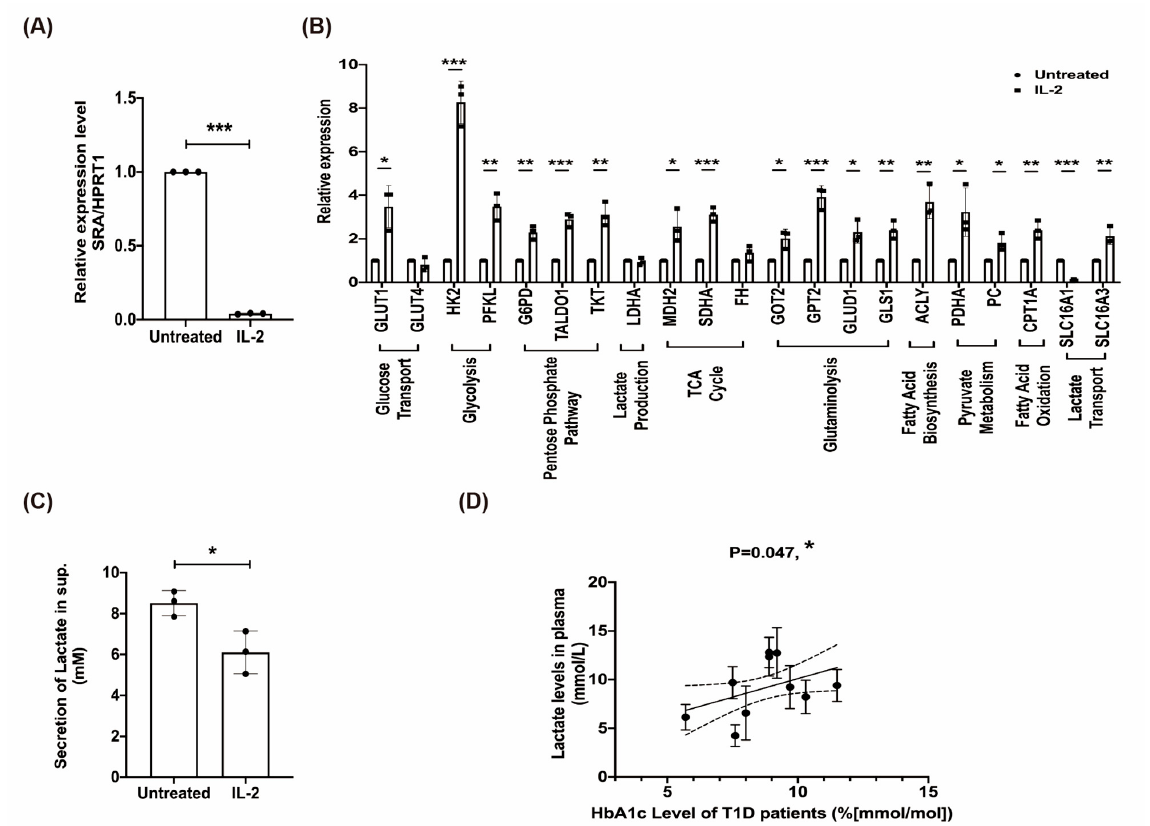
Figure 6. The effect of recombinant human IL-2 (rhIL-2) treatment on the expression of lncRNA SRA, metabolic pathways in MIN6 β -cells, and lactate associated with poor clinical outcome. The cellular expression of ( A ) SRA was assessed in cells using real-time qPCR after 48 h of treatment with rhIL-2 (200 units/mL) and compared with that of the untreated control cells. * significant changes compared with the control or untreated cells ( p < 0.001). ( B ) Real-time qPCR analysis showed the metabolic pathway in shSRA versus shCon-transduced MIN6 β -cells. ( C ) Lactate production of rhIL-2 treatment (300 units/mL) for MIN6 β -cells. ( D ) Correlation between lactate level and HbA1c level in plasma from patients with T1D. Mean ± SD, Student’s t -test (unpaired, two-sided). * p < 0.05, ** p < 0.01, *** p < 0.001.